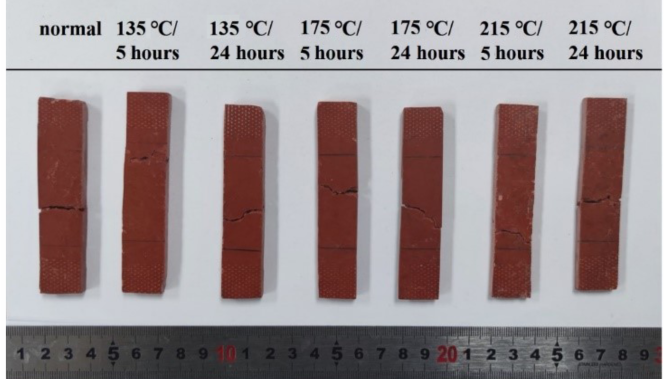
Figure 9. The appearance of the specimens after the tensile